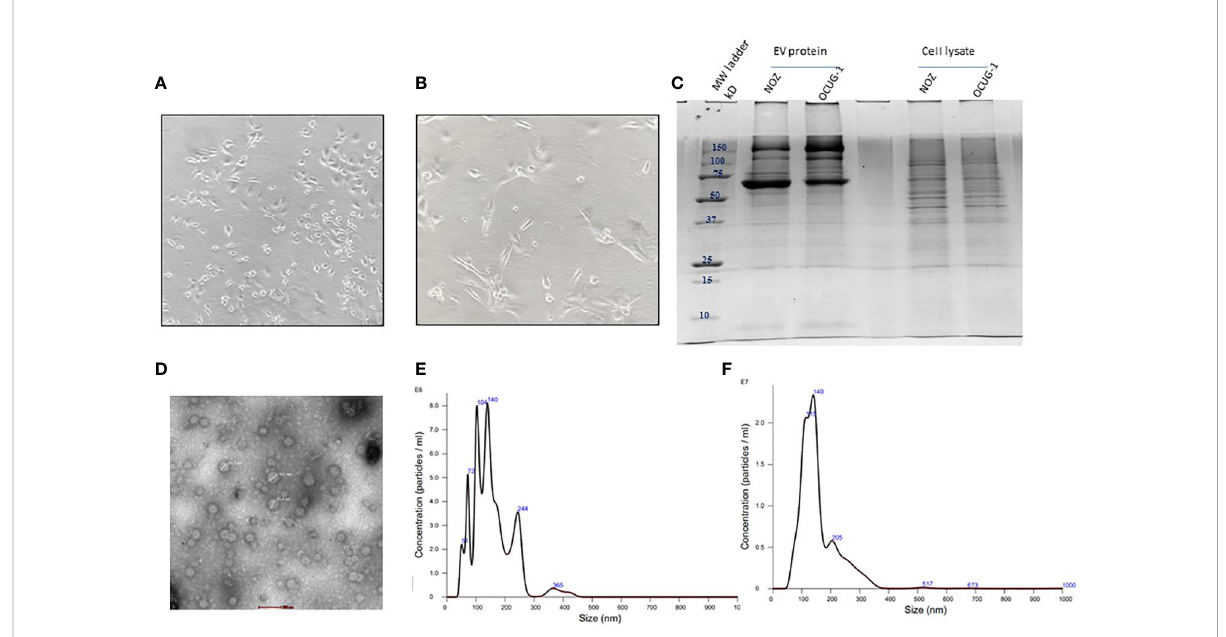
FIGURE 2 Characterization of GBC cell line-derived EVs. Representative image of GBC cell line NOZ (A) and OCUG-1 (B) . SDS-PAGE pro fi le of GBC cell line-derived EV proteins and cell lysate (C) . Transmission electron micrographs of cell line- derived EVs. EVs from cell lines were isolated by ultracentrifugation method were resuspended in PBS and loaded on 2% carbon coated grids. Negative staining was performed using 2% phosphotungstic acid (PTA). Images of EVs (40-100 nm) were acquired using 200KV, TECNAI G20 HR-TEM, Thermo Scienti fi c at 1,00,000× magni fi cation, scale bar- 100 nm (D) Size and particle distribution plots of EVs from GBC cell line-derived EVs using nanoparticle tracking system showed peaks at 140 nm and 139 nm for NOZ (E) and OCUG-1 (F) respectively suggesting enrichment of exosomes in the EV